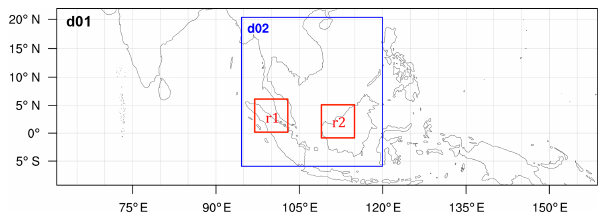
Figure 1. Domain configuration for WRF-Chem simulations. Do- main 1 (d01) has a resolution of 25km, while Domain 2 (d02) has a resolution of 5km. Two red boxes indicate the two study regions: the Sumatra region (r1) and the Borneo region